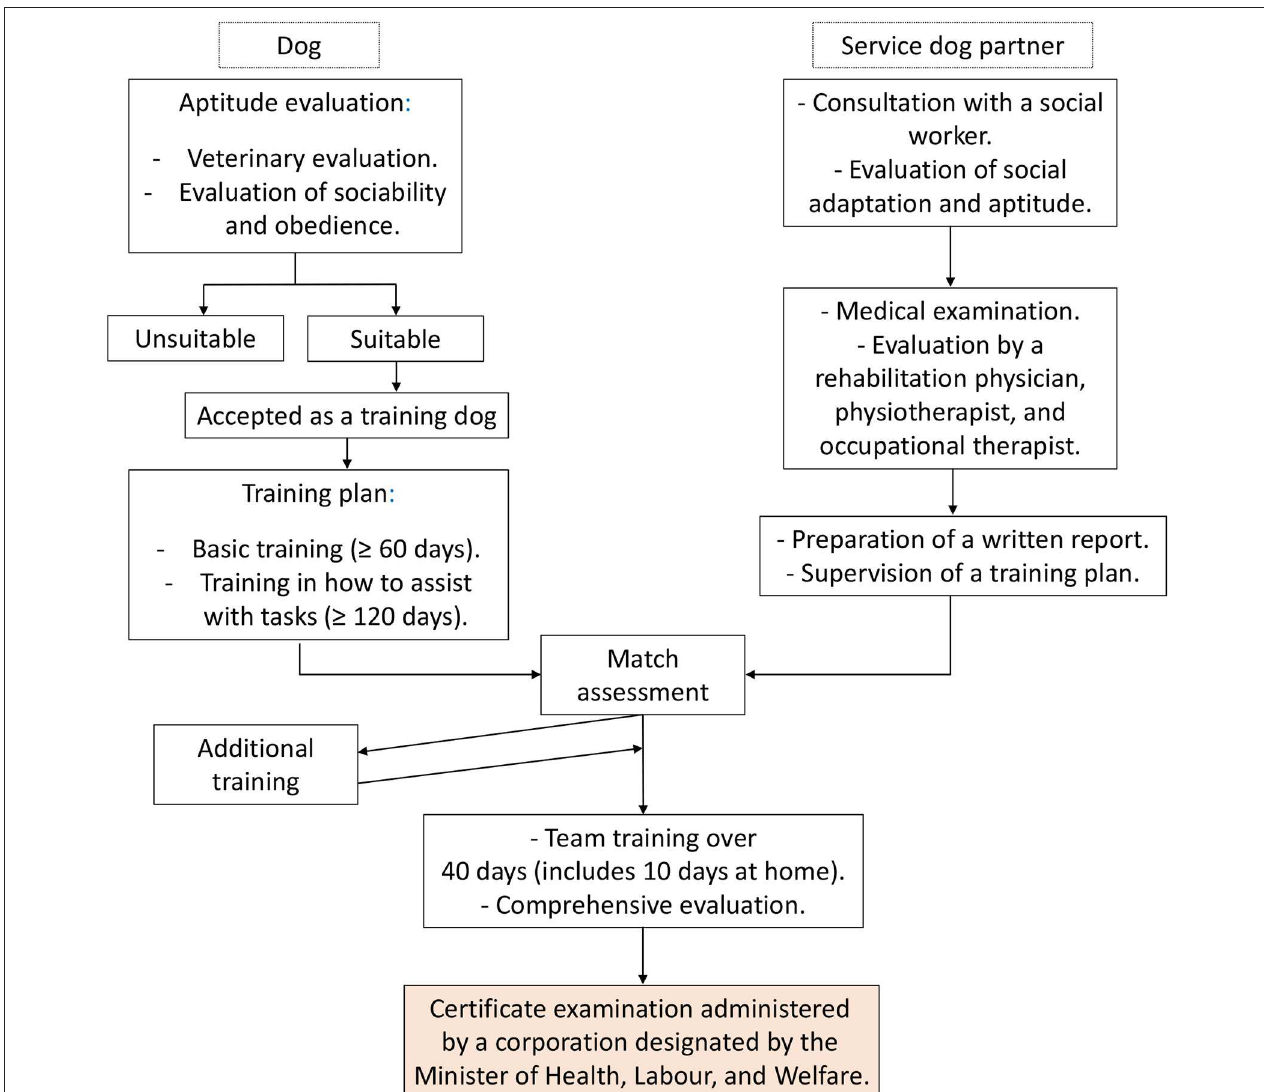
FIGURE 2 | A flow chart of the certification procedure at the Yokohama City Rehabilitation Center, Kanagawa, Japan. The upper left side of the flow chart depicts the training of a service dog, while the upper right side details the evaluation of a person in terms of eligibility for being a service dog partner. Team training only begins once the person is deemed to be eligible. The team is certified once it has passed a final certificate examination that is administered by a corporation that has been designated by the Minister of Health, Labor, and